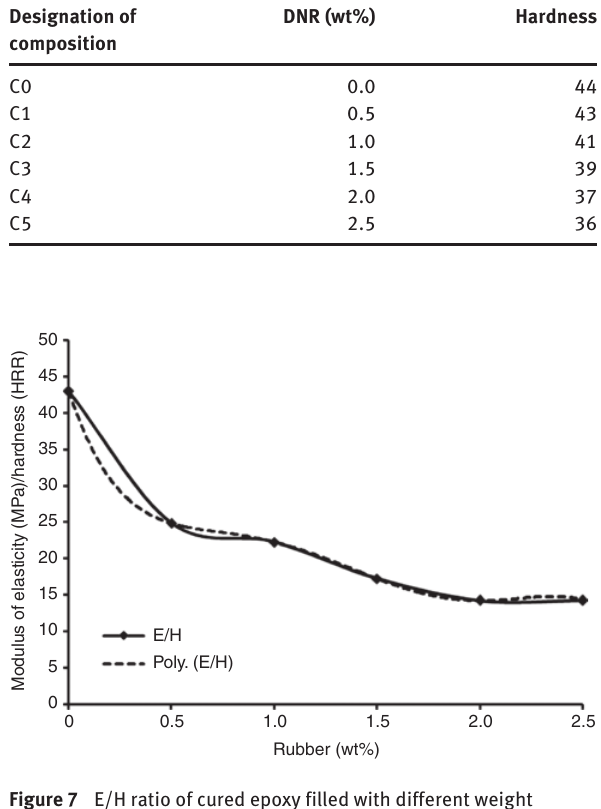
Figure 7 E/H ratio of cured epoxy filled with different weight percentages of DNR.